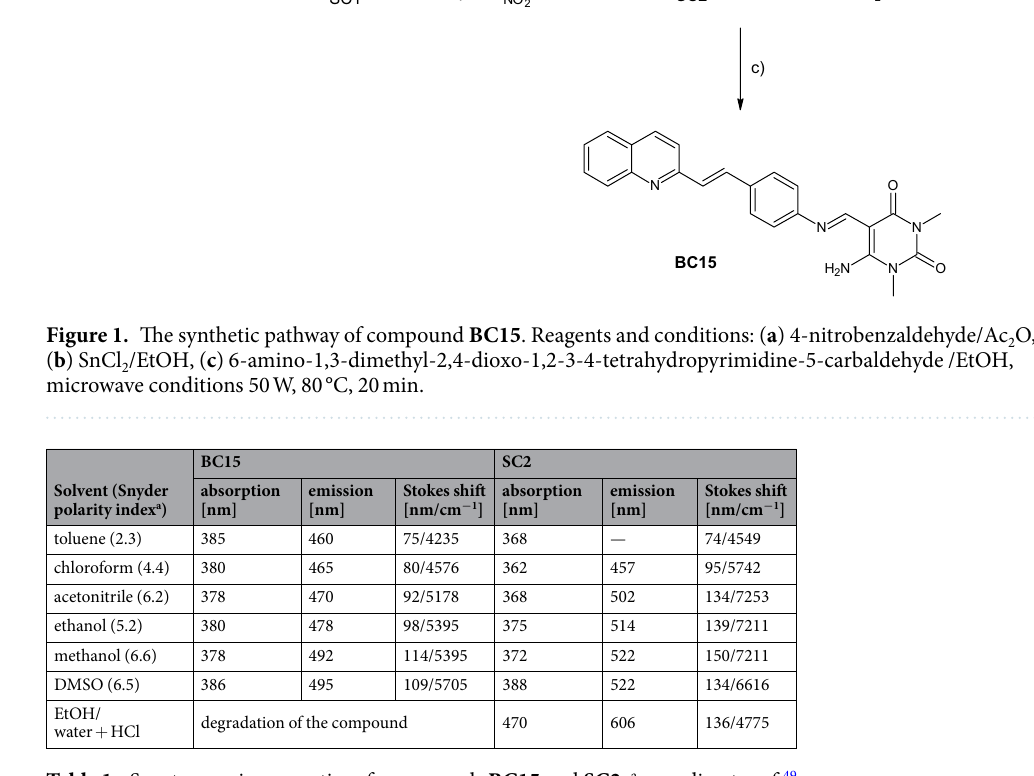
Table 1. Spectroscopic properties of compounds BC15 and SC2 . a according to ref. 49